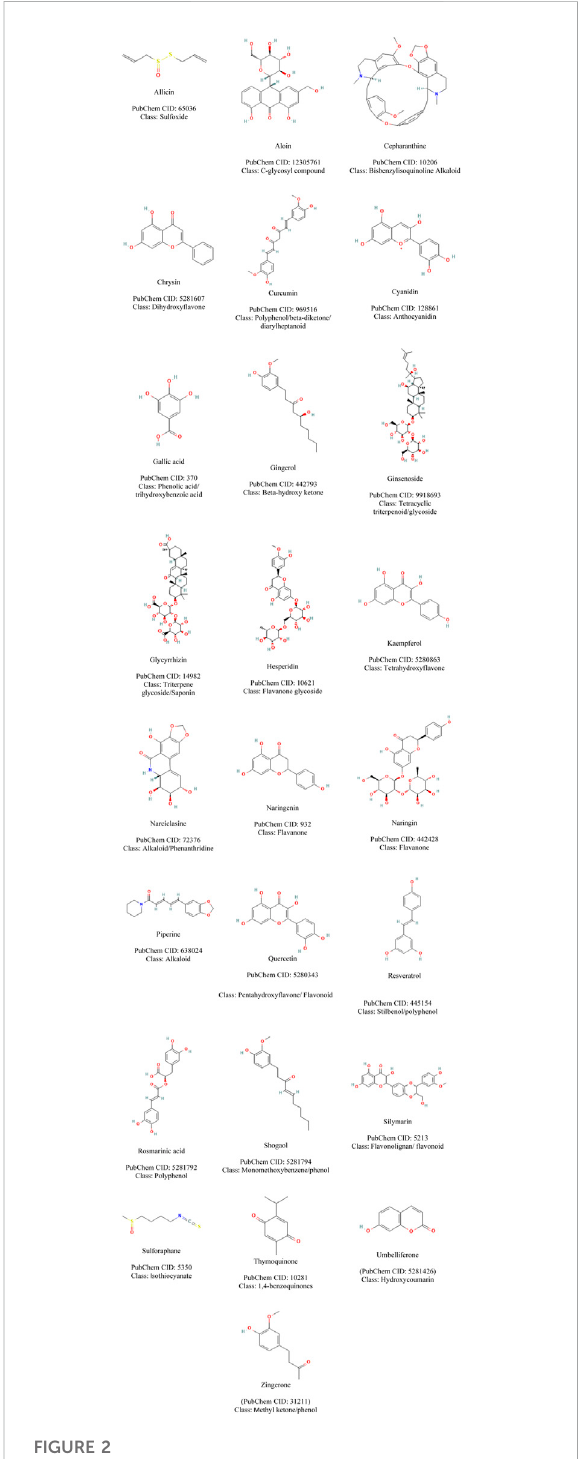
Plants ’ secondary metabolites effective in the management of